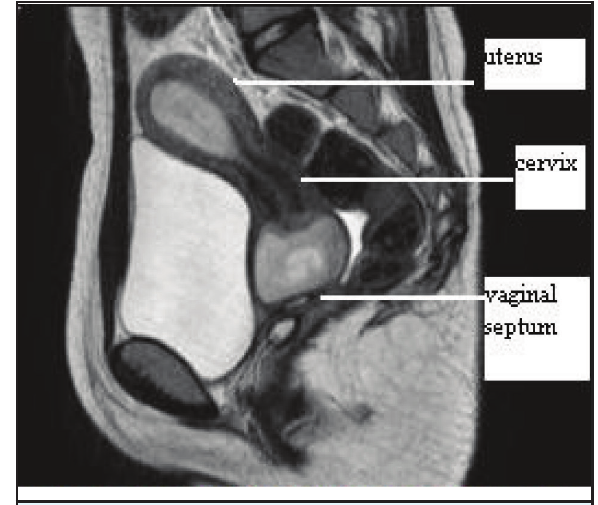
Figure 2. First Post operative MRI film: After first surgery showing refused vaginal septum with pyocolpos, and formed cervix.